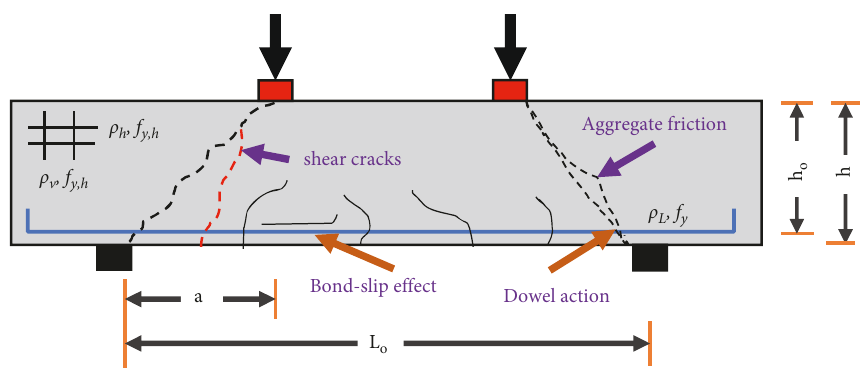
Figure 1: Failure types on reinforced deep